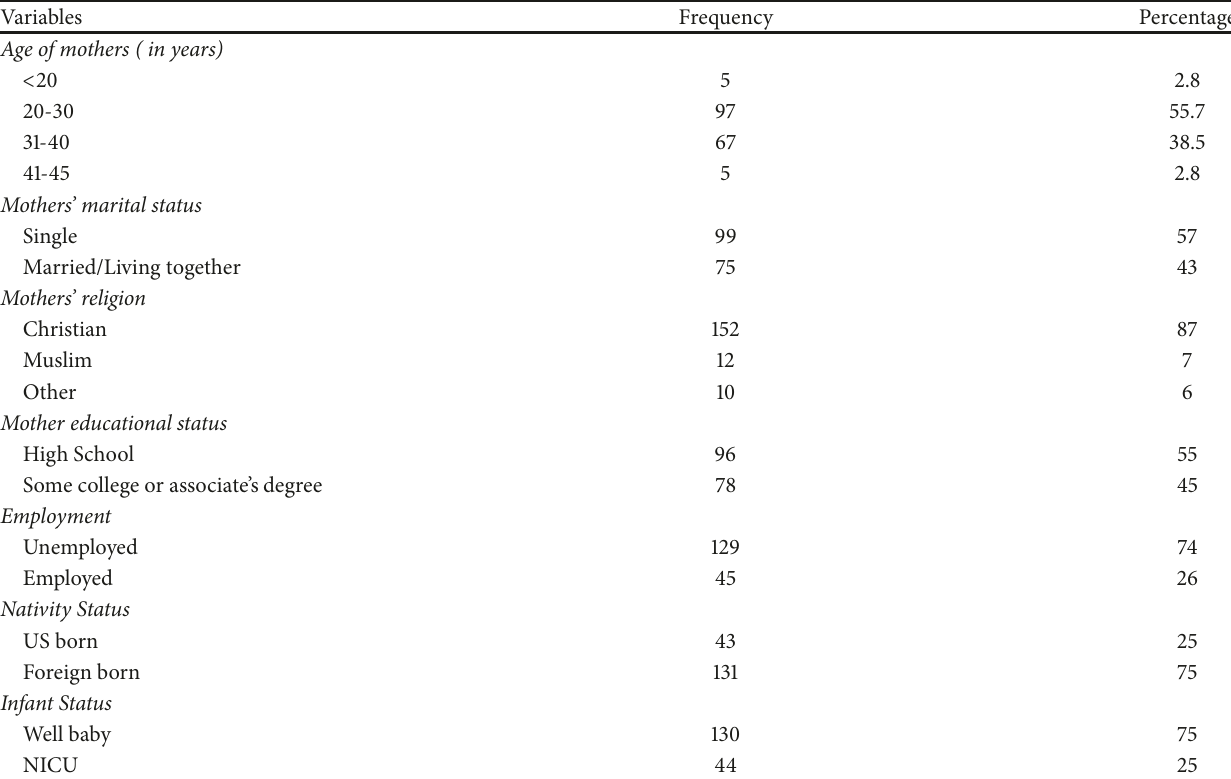
Table 2: Sociodemographic data of mothers